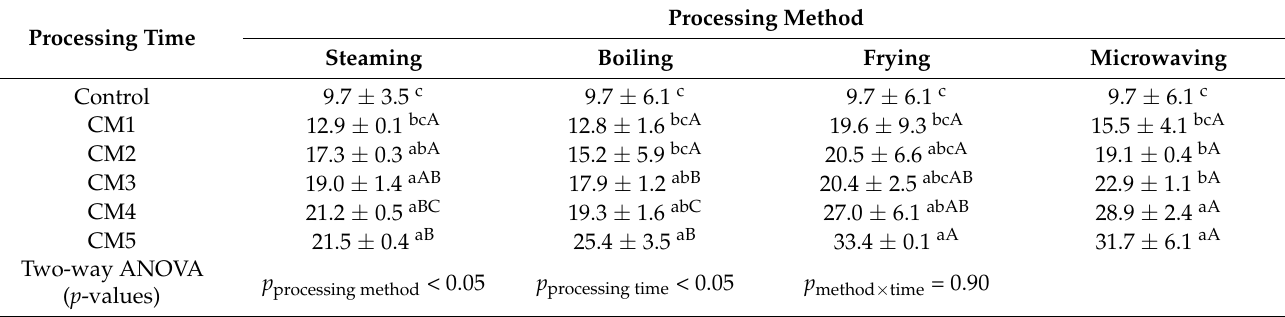
Table 4. Comparison of the shearing force (kg) of camel meat after different heat processing